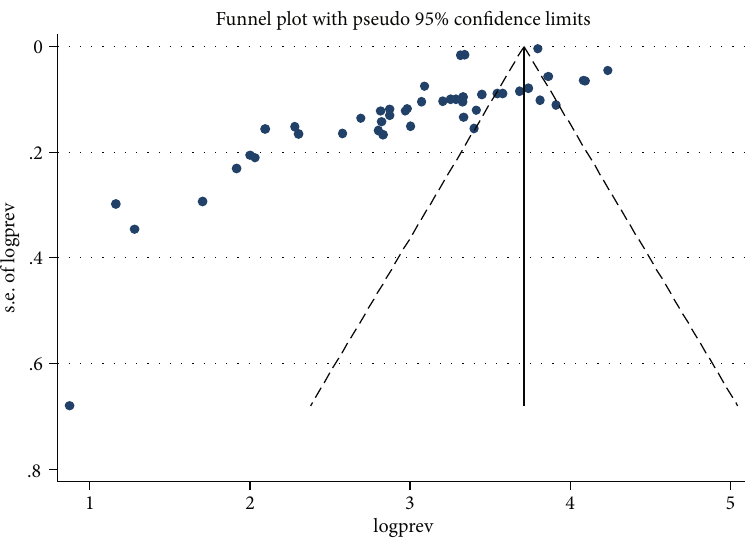
Figure 6: Funnel plot indicates publication bias among